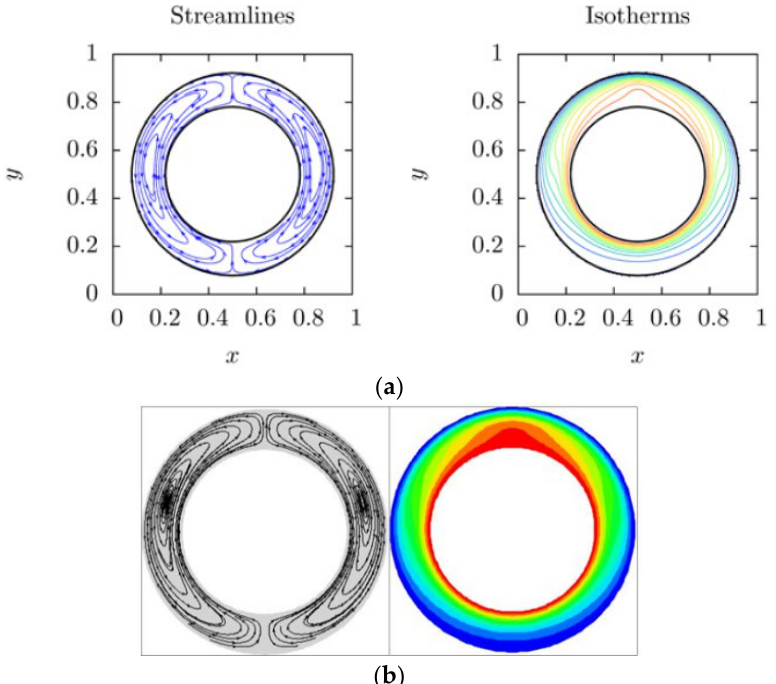
Figure 3. ( a ) The literature, ( b ) this work. Comparison of streamlines and isotherms obtained in this work and the literature. Table 2. Effect of the grid size on the average Nusselt number.